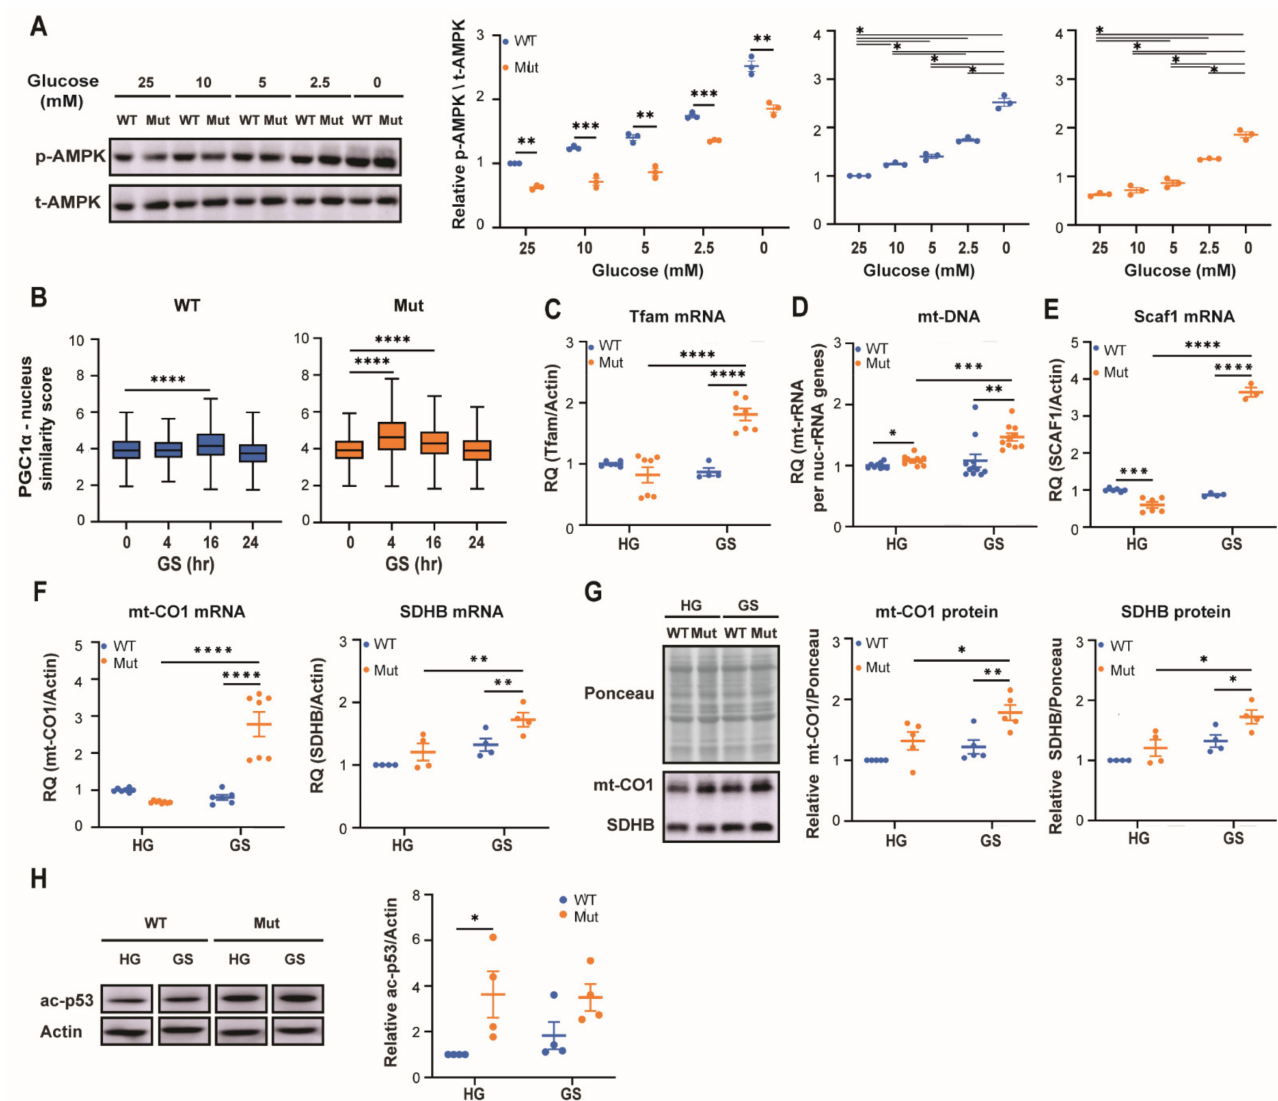
Figure 2. Impact of energy stress on AMPK activity and its downstream effector in WT (blue) and Mut (orange) primary astrocytes. ( A ) Immunoblot analysis of p-AMPK and t-AMPK following 48 h incubation with the indicated glucose concentrations. ( B ) PGC1 α nuclear localization represented by boxplots showing the median, minimum and maximum similarity scores of PGC1 α and DAPI fluorescence signals obtained from 3 × 10 3 cells, analyzed at each of the indicated time points along glucose starvation. Representative images shown in Supplementary Figure S3. ( C , E , F ) RT-qPCR analysis of Tfam, Scaf-1, mt-CO1 and SDHB per actin mRNA levels following 48 h incubation in DMEM-HG or DMEM-GS medium. Data represent average of RQ values per actin mRNA. ( D ) Quantification of mitochondrial DNA (mtDNA) following 48 h incubation in DMEM-HG or DMEM-GS medium. Data represent average of RQ values of DNA encoding mitochondrial 12S rRNA per nuclear 18S rRNA genes. ( G ) Immunoblot analysis of mt-COI and SDHB protein levels following 48 h incubation in DMEM-HG or DMEM-GS medium. Data represent average of the ratio of mt-CO1 or SDHB band intensity per total protein in the lane as quantified by Ponceau staining. ( H ) Immunoblot analysis of acetylated-p53 (ac-p53) and actin protein levels following 48 h incubation in DMEM-HG or DMEM-GS medium. Data represent average of ac-p53 per actin ratio. Representative blots are shown. All graphs except for B show the average values ± SEM relative to WT-HG. Statistical analysis is detailed in Materials and Methods. * p ≤ 0.05, ** p ≤ 0.01, *** p ≤ 0.001, **** p ≤